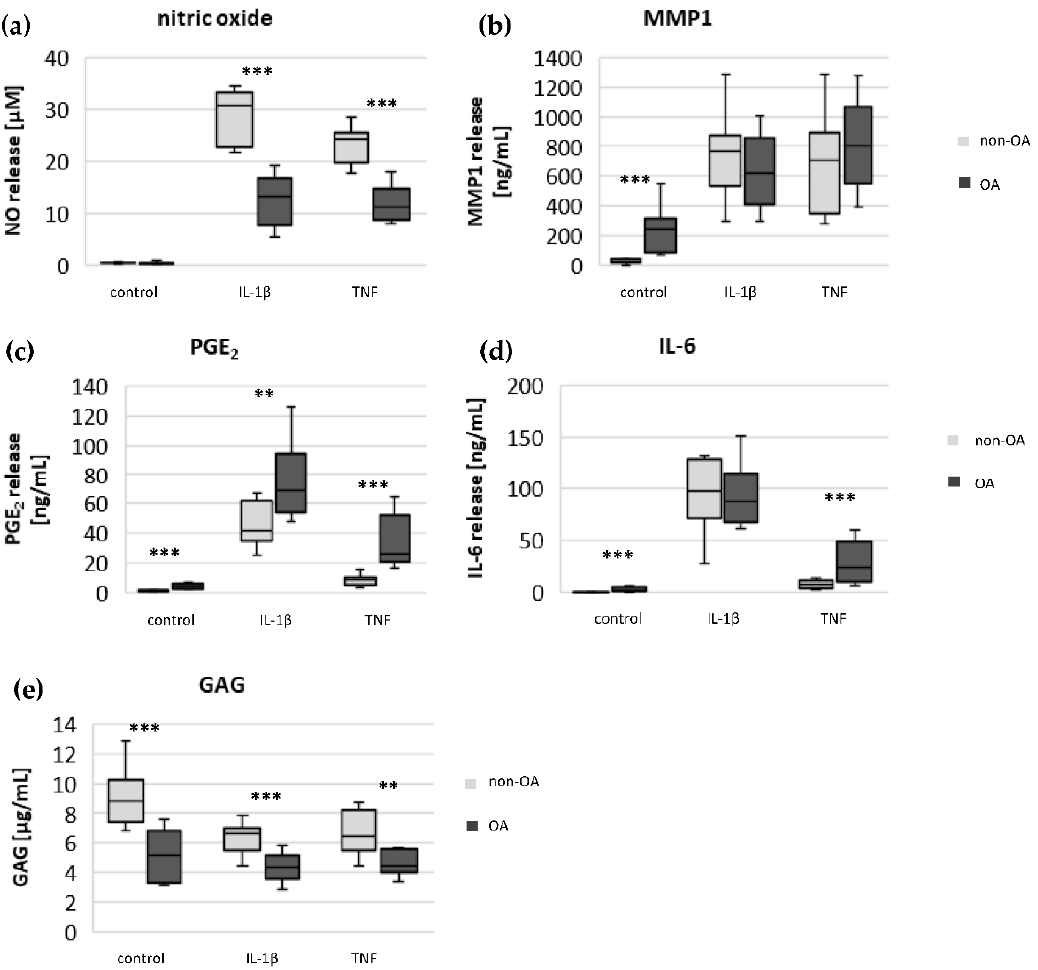
Figure 5. Impact of IL-1 β and TNF on the release of NO ( a ), MMP1 ( b ), PGE 2 ( c ), IL-6 ( d ) and GAG ( e ) in non-OA (number of patients = 8) and OA (number of patients = 10) human hip chondrocytes. Values are displayed as box plots. Statistics: non-OA vs. OA chondrocytes, Mann–Whitney U Test, *** p < 0.005, ** p < 0.01. Control: unstimulated cells.